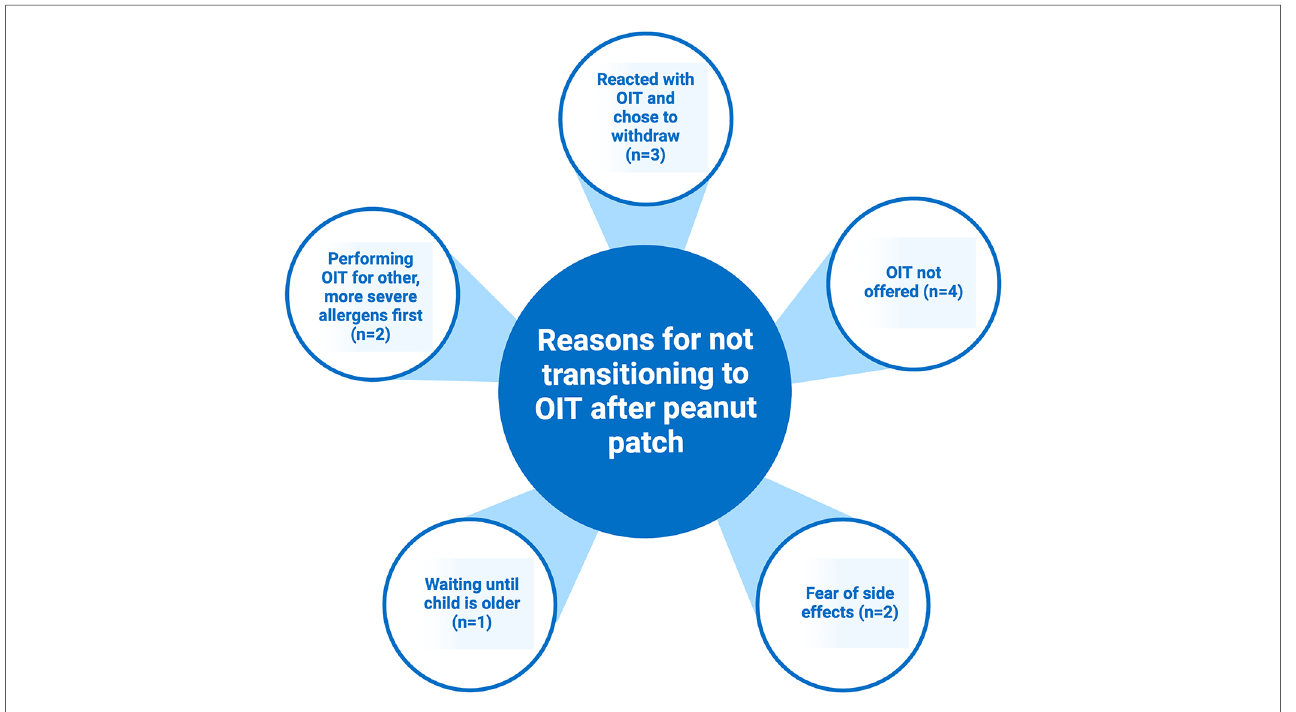
FIGURE 3 Reasons families chose not to transition to OIT after peanut